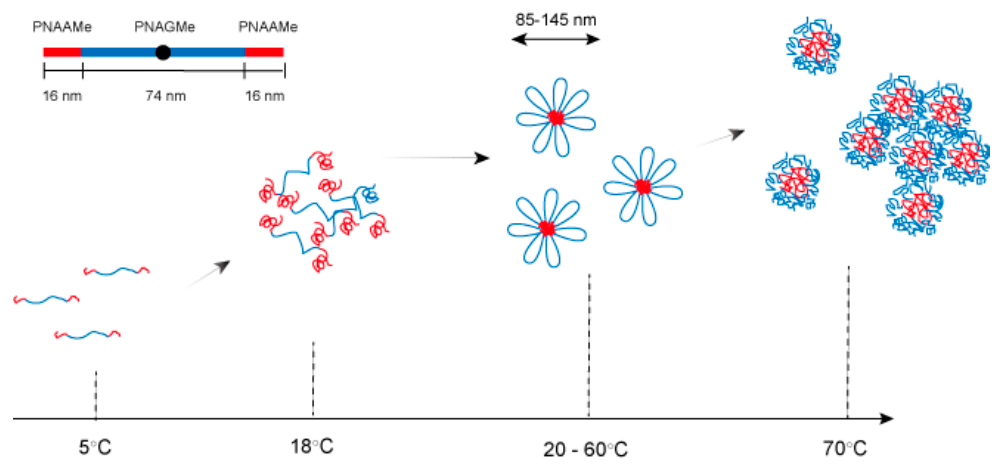
Figure 3. Plausible model for the thermo-responsive transitions of poly(NAAMe 53 - b -NAGMe 240 - b - NAAMe 53 ) through various aggregation states containing flower-like micelle formation.